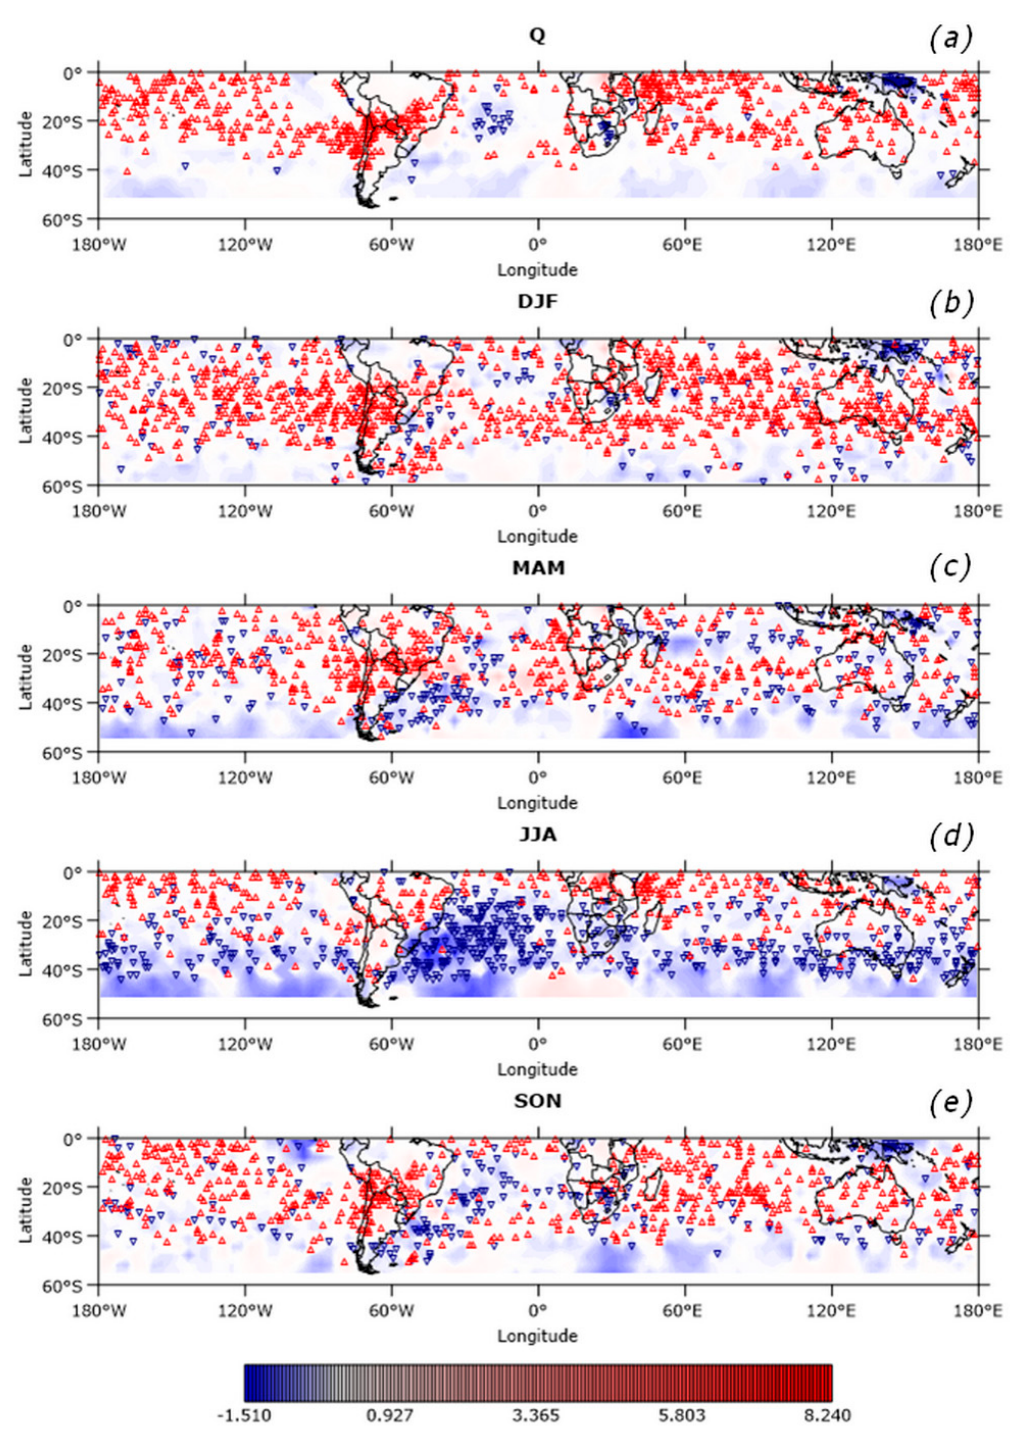
Figure 4. As in Figure 3 but for the SO 2 seasonal concentrations in the middle troposphere (TRM). Q, DJF, MAM, JJA and SON figures are shown in panels ( a – e ), respectively.